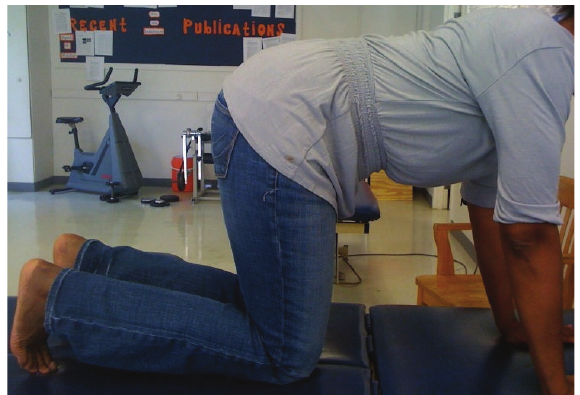
Figure 2: Starting position for the quadruped exercise.